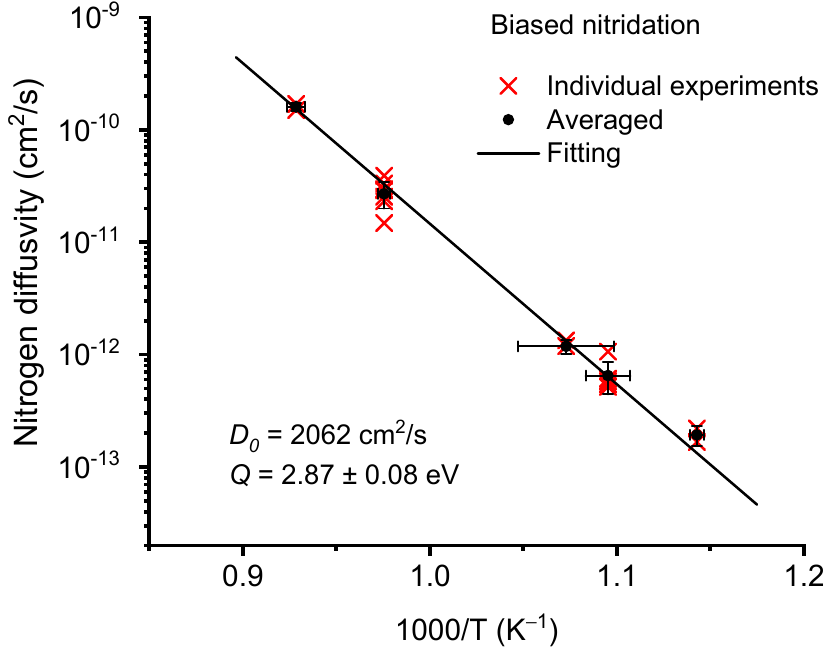
Figure 10. Arrhenius plot for nitrogen diffusivity in Zircaloy-4 as a function of nitridation temperatures for biased nitridation.